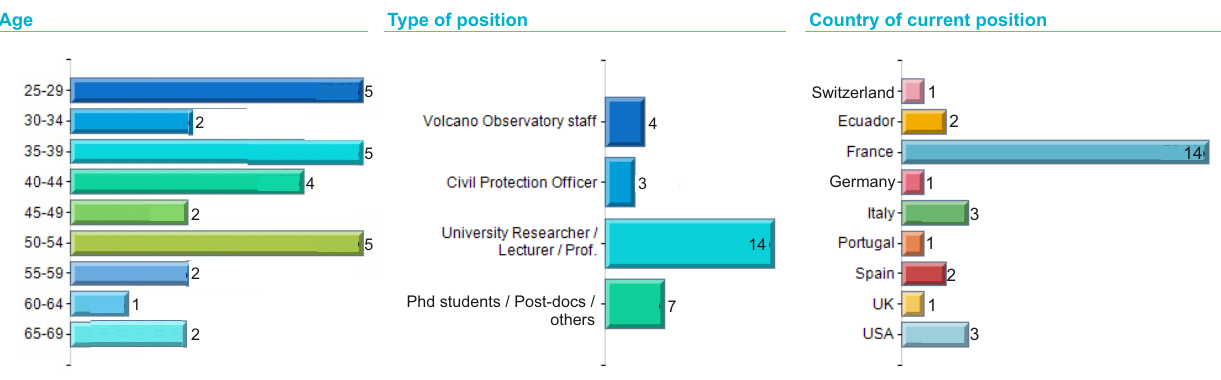
Figure 2: Group composition sorted by age, type of position and country of current